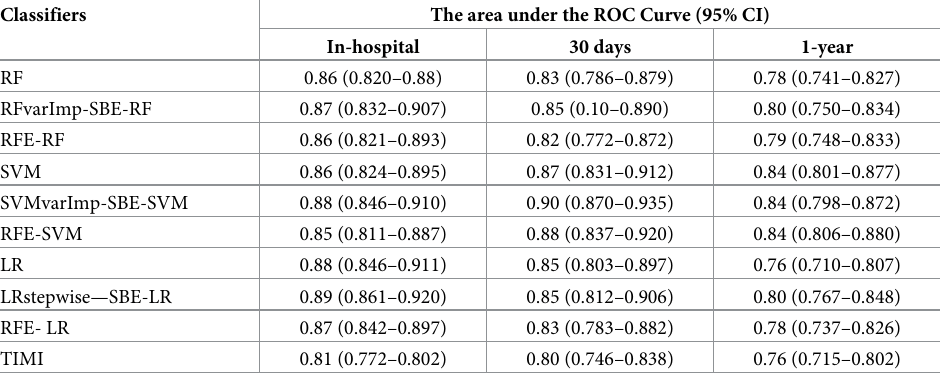
Table 2. The AUC of TIMI risk score and ML models with and without feature selection based on a 30% validation